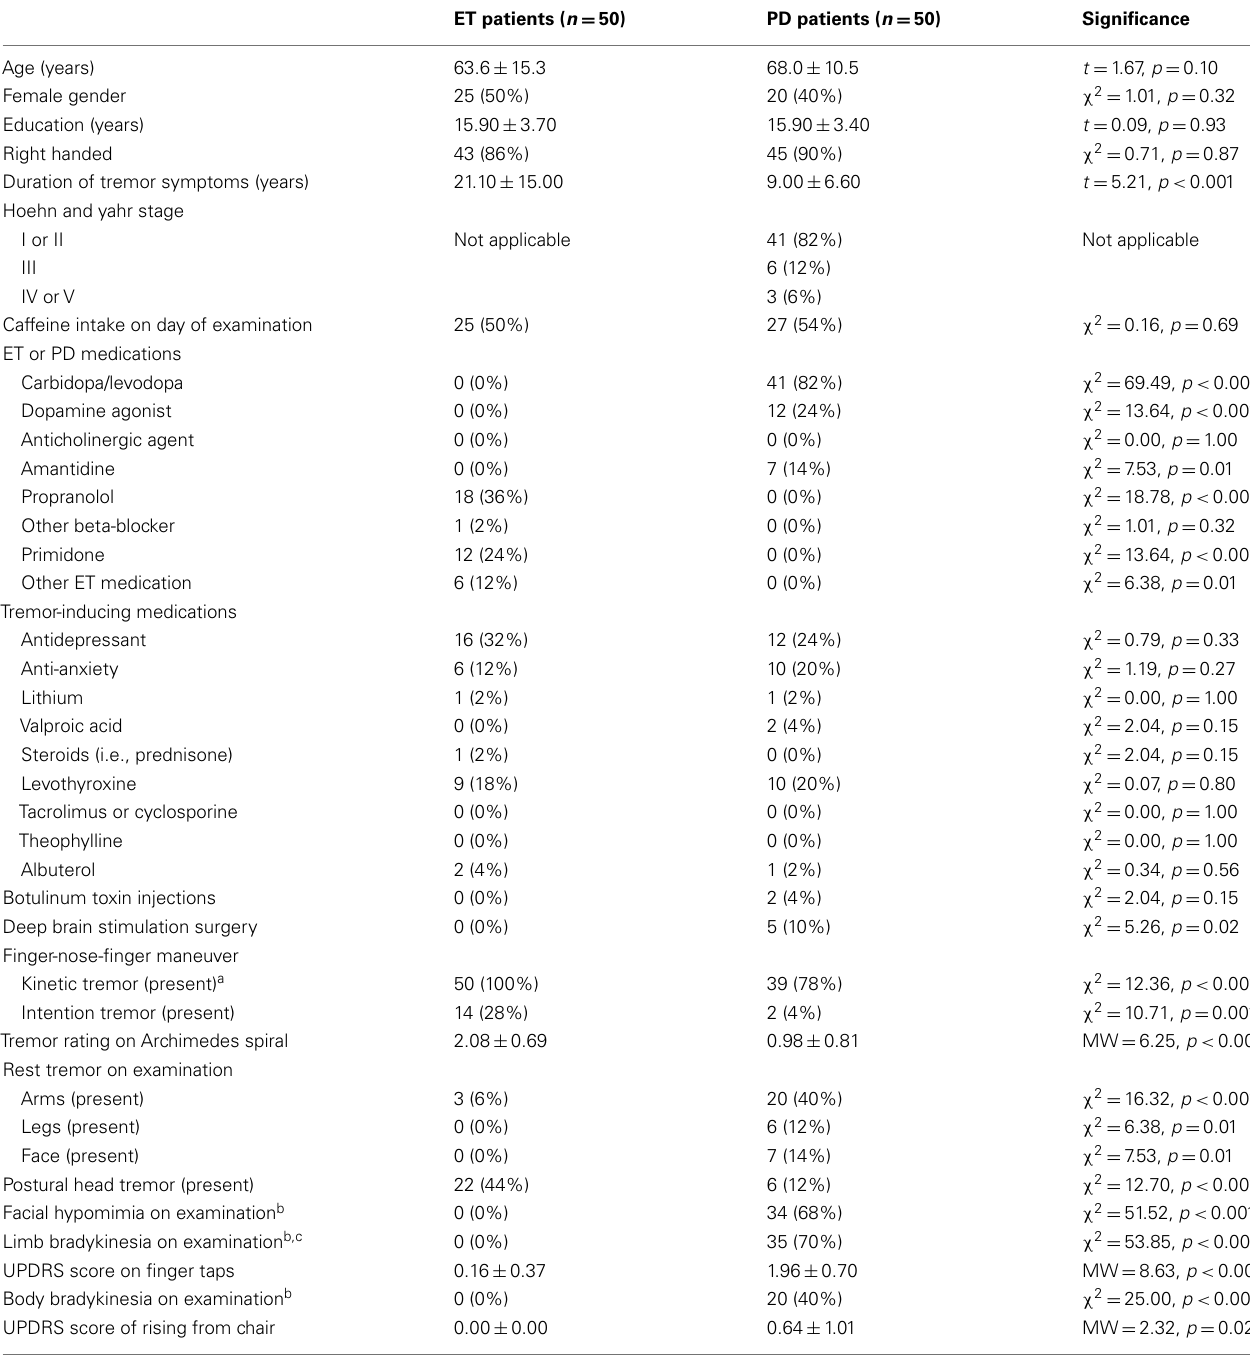
Table 1 | Demographic and clinical characteristics of ET and PD